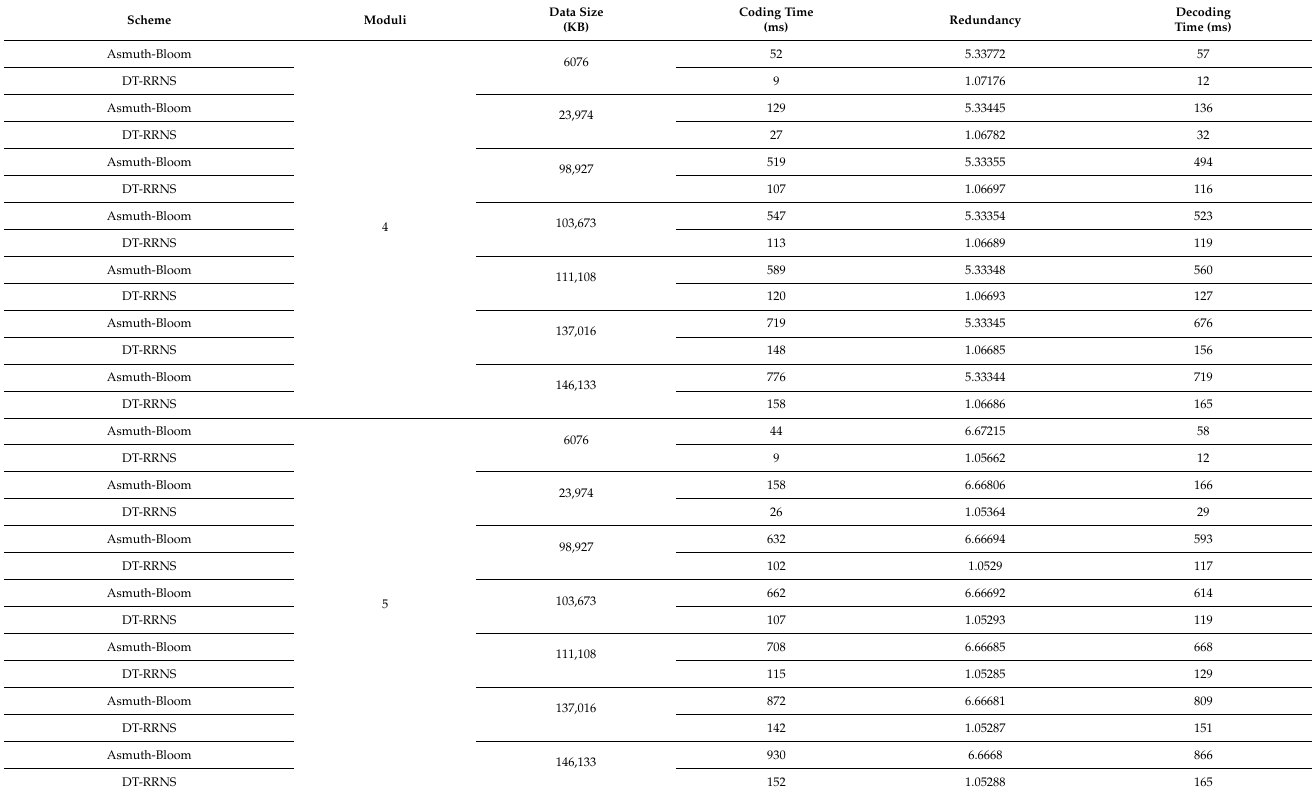
Table 3. The coding and decoding time and